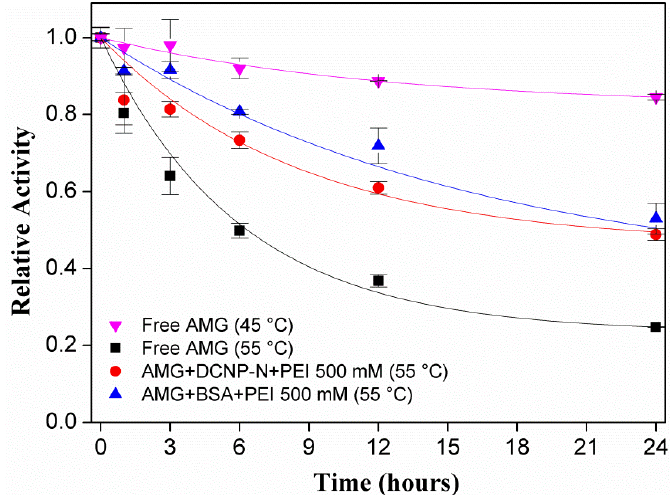
Figure 14. Profile of thermal inactivation of free amyloglucosidase (AMG) and AMG CLEAs prepared by enzyme treatment with polyethyleneimine (PEI) and by co-aggregation with the magnetic nanoparticles DCNP-N or bovine serum albumin (BSA) at 45 and 55 °C and pH 4.5 (50 mM sodium citrate buffer). Values are shown as the mean of triplicate experiments ± s.d. Table 4. Half-life times (t 1/2 ) and stability factor (SF) for amyloglucosidase (free and immobilized AMG) at 55 °C and pH 4.5.